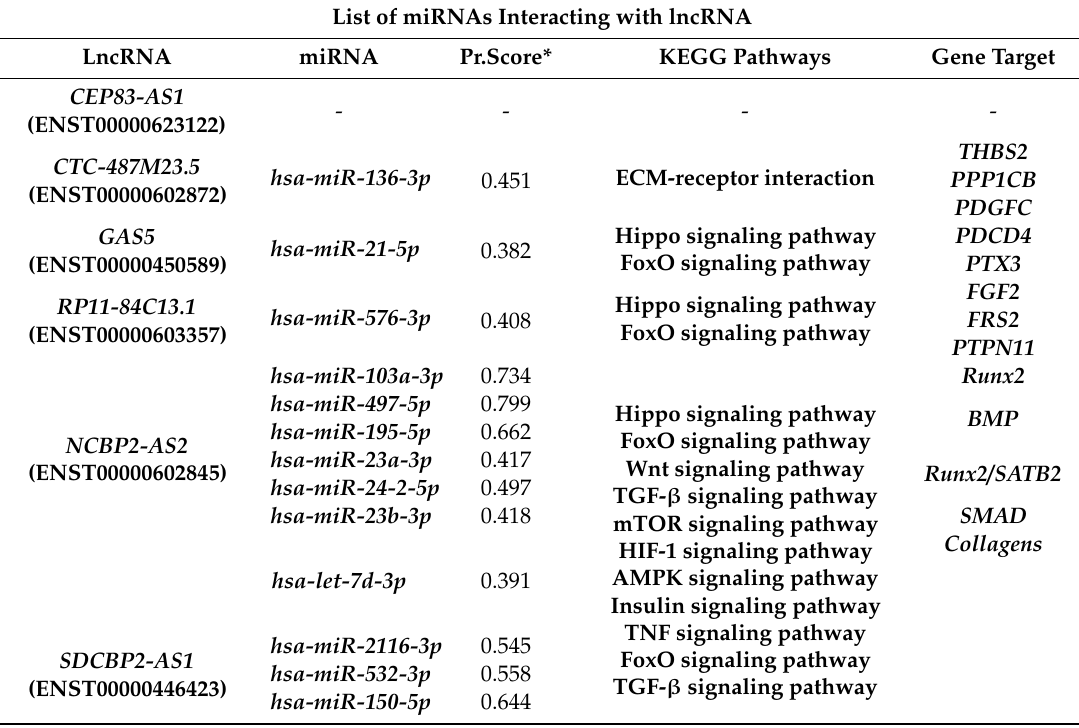
Table 4. List of interactions between lncRNAs and putative miRNA-targeted proteins and pathways. List of miRNAs Interacting with